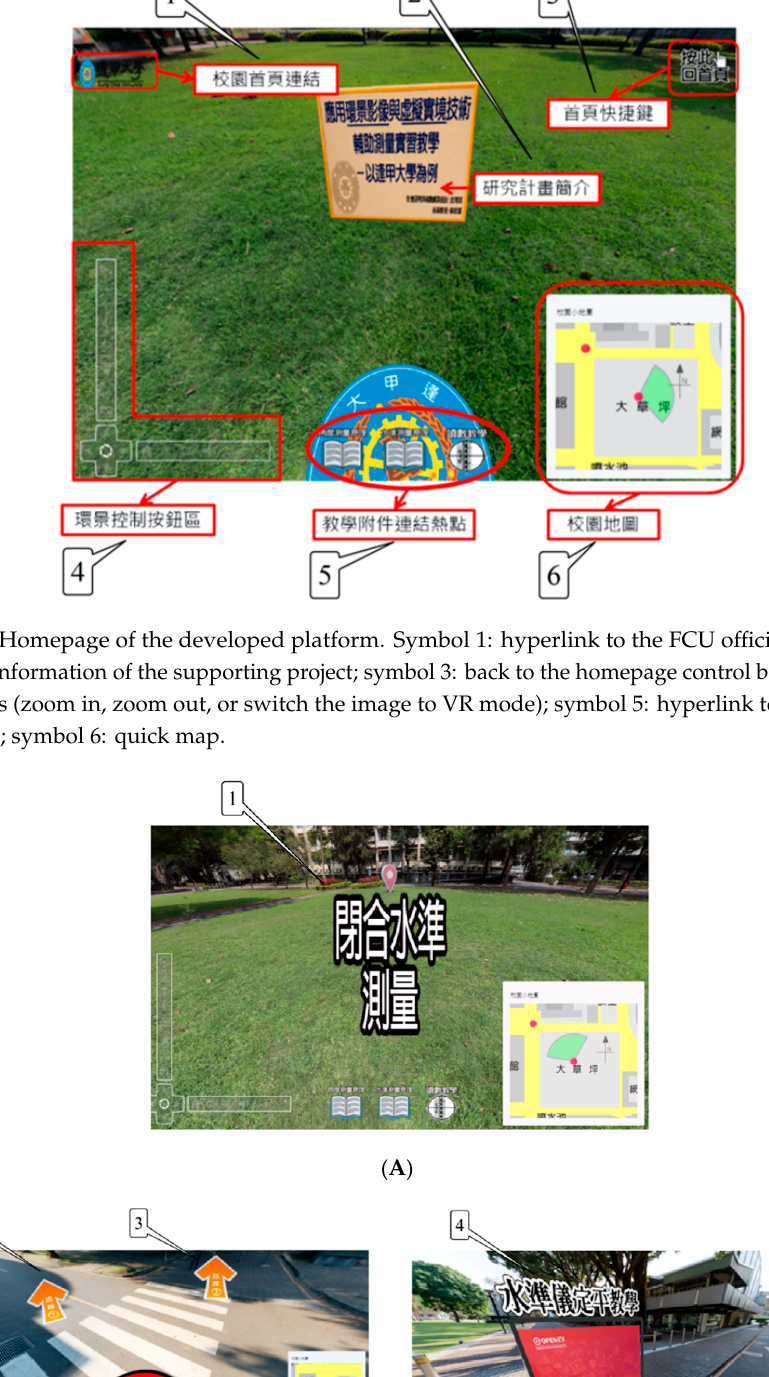
( C ) Figure 12. Webpage for teaching the angle-based measurement. ( A ) Entrance for angle-based measurement (symbol 1); ( B ) Aimed direction from left for measurement (symbol 2) and how to record the observations (symbol 3); ( C ) Teaching video for setting up the instrument with VR mode. 4.4. Questionnaire-Based Results We received 62 questionnaire responses from the participating students; the statistical results are listed in Table 3. A higher score indicates stronger approval of the use of the designed platform and information technologies in teaching. Q1 and Q2 aimed to investigate the effectiveness of the designed platform in teaching as well as its content display, and Q3 and Q4 attempted to determine whether the use of information technologies helps strengthen learning interest. Most of the ratings for these four questions were > 4 (92% of the total responses), signifying positive feedback from